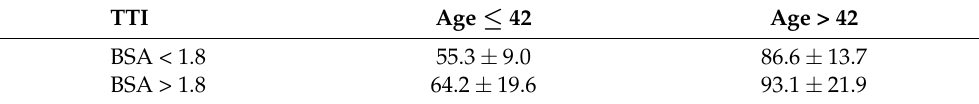
Table 4. TTI mean ± SD ( Ω ) in relation to age (in years) and BSA (in m 2 ) with n = 20 [42].